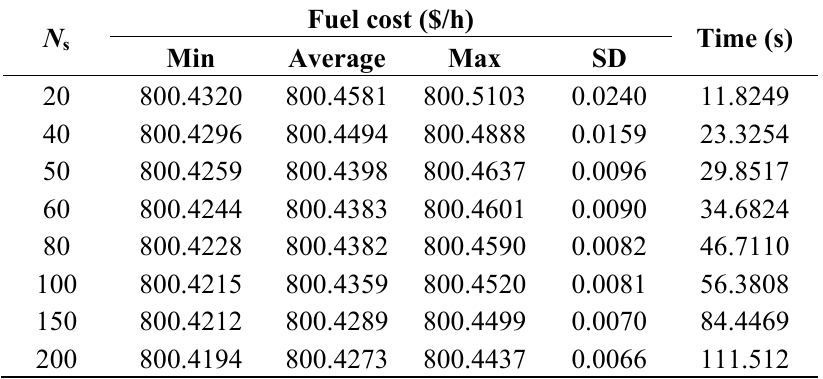
Table 1. Results obtained by the IABC algorithm with different N s values for OPF with total fuel cost.